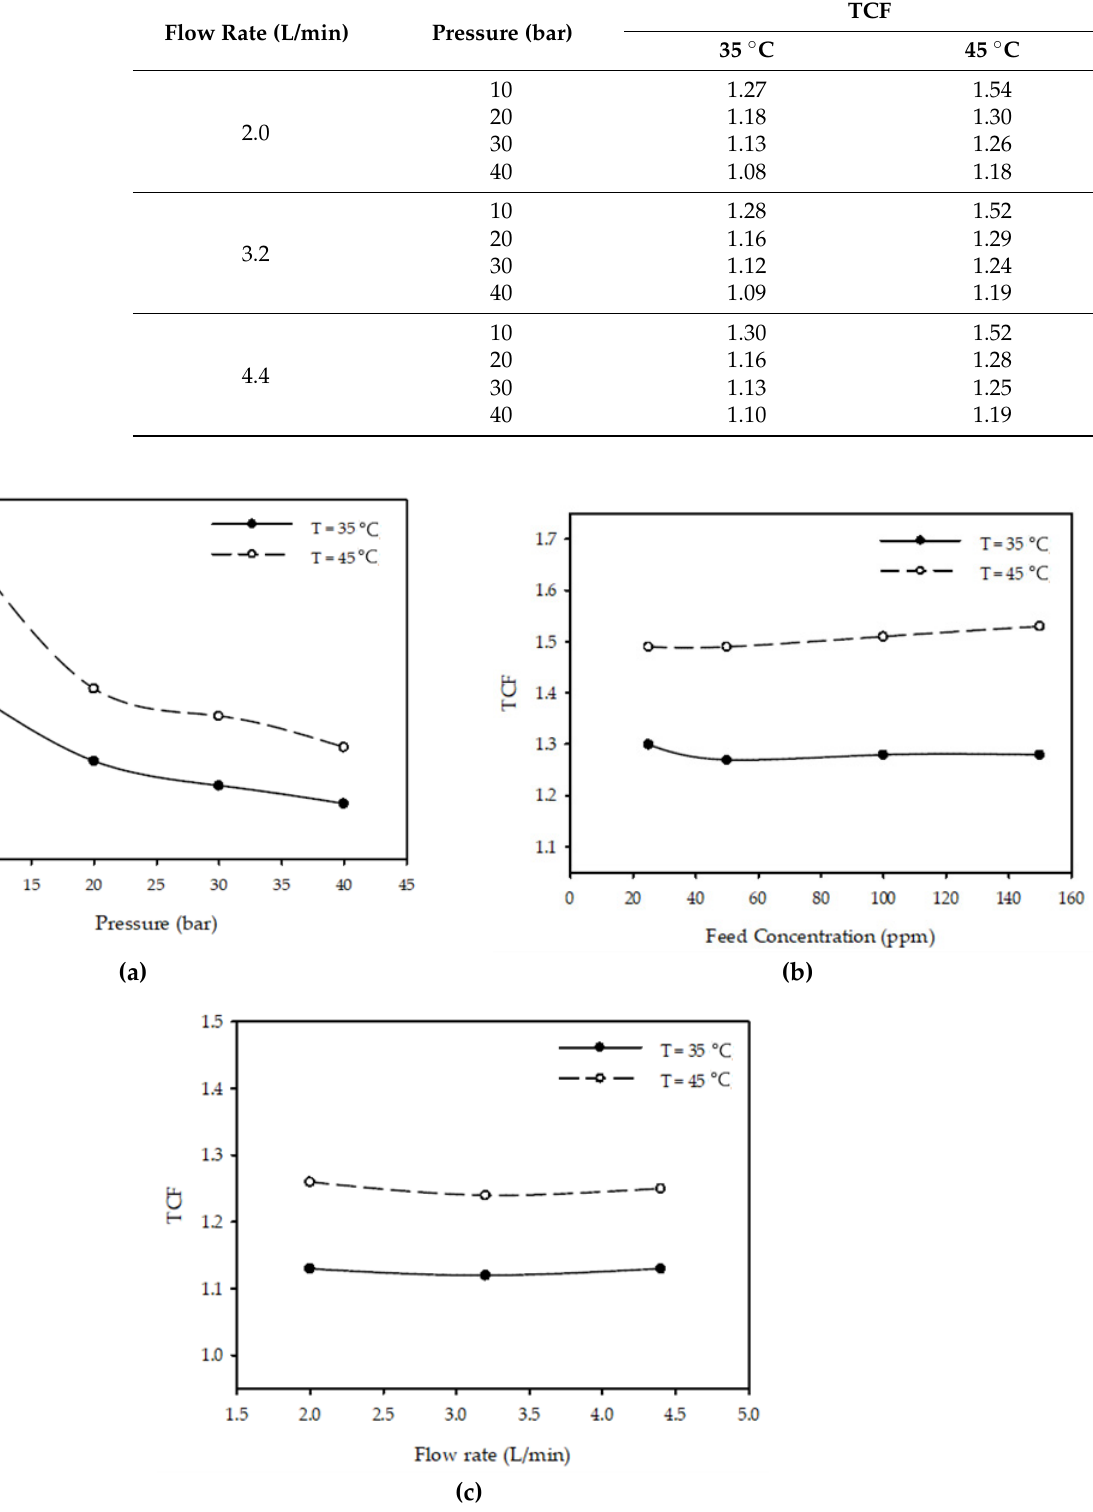
Figure 6. Effect of ( a ) pressure (3.2 L/min, 100 ppm), ( b ) feed concentration (20 bar, 3.2 L/min), and ( c ) flow rate (30 bar, 100 ppm) on TCF at different temperatures.